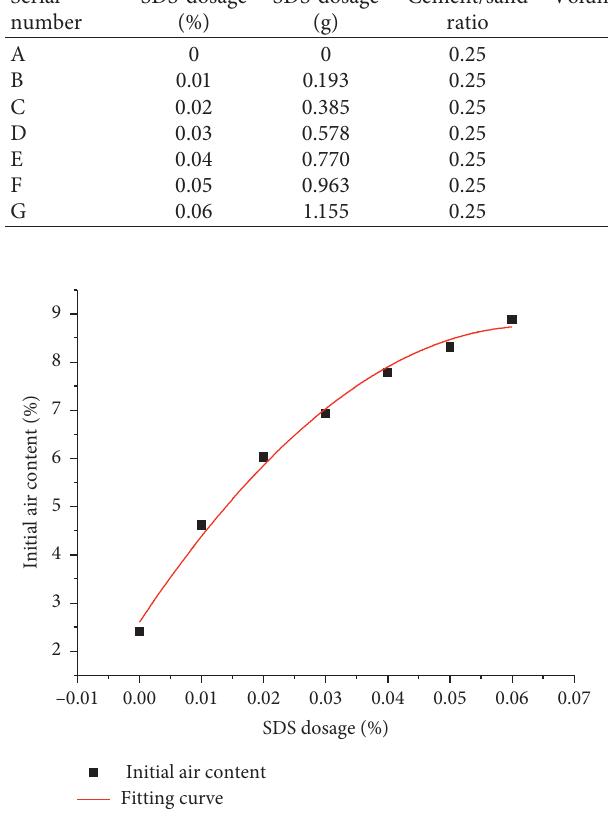
Figure 3: Relationship between the SDS dosage and the initial air content in fresh slurry.